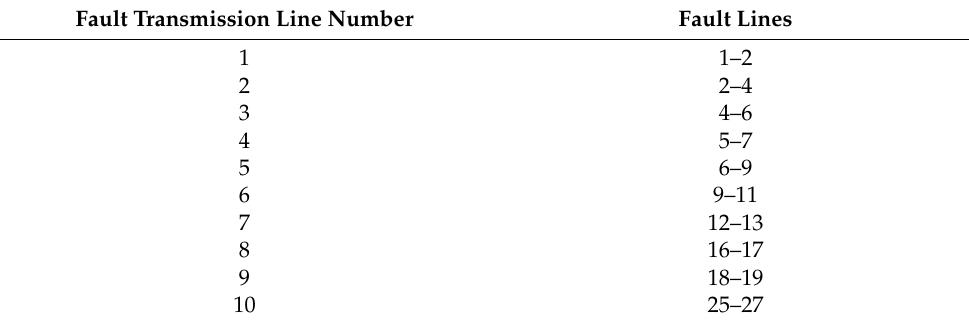
Table 1. Contingency set of IEEE 30 bus system.